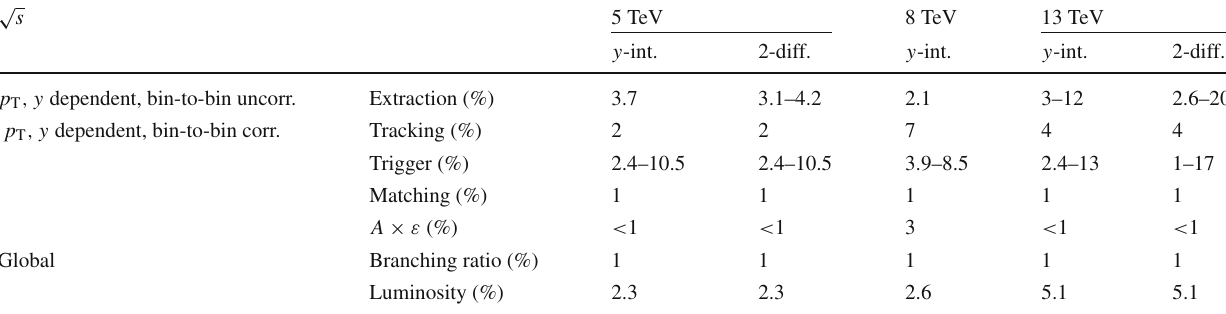
y -int. 2-diff. y -int.